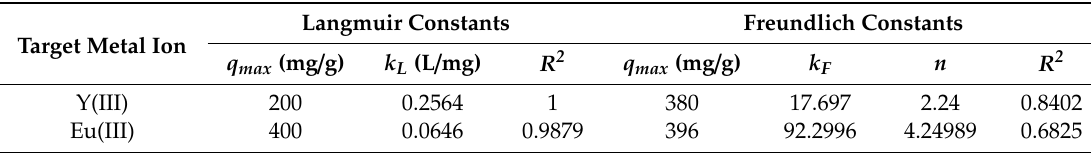
Table 2. Langmuir and Freundlich constants and correlation coefficients